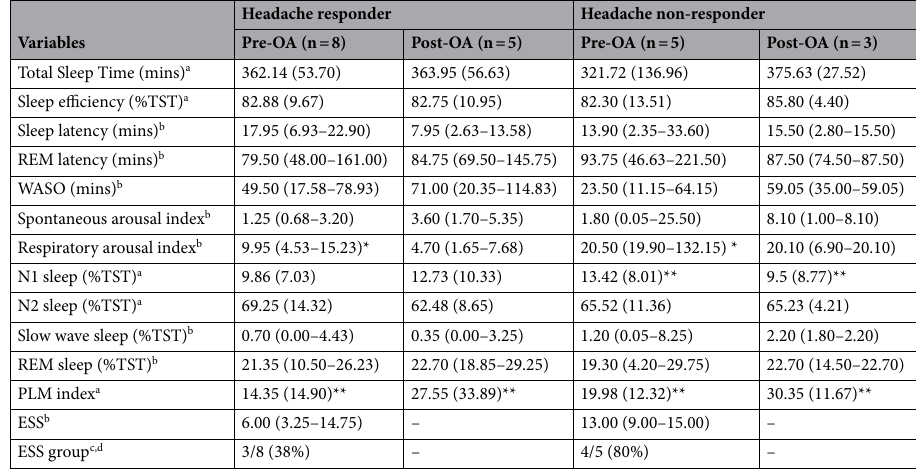
Table 4. Polysomnographic characteristics according to headache responder group-sleep architecture, oxygen saturation, limb movement, and sleepiness. OA oral appliance, TST total sleep time, REM rapid eye movement sleep, WASO wake after sleep onset, N non rapid eye movement sleep, PLM periodic limb movement, ESS Epworth Sleepiness Scale. *Significant difference: P < 0.05, comparison between headache responder and non-responder. **Significant difference: P < 0.05, comparison between pre- and post-oral appliance treatment. a Differences between groups were tested with t-test and pre- and post-OA data were tested with paired t-test: Mean (SD). b Differences between groups were tested with Mann–Whitney test and pre- and post-OA data were tested with Wilcoxon Rank-sum test: Median (lower quartile-upper quartile). c Differences between groups were tested with Chi-square test. d Results given as number of patients with excessive daytime sleepiness (ESS > 10)/total number of patients (percentage of patients with excessive daytime sleepiness).